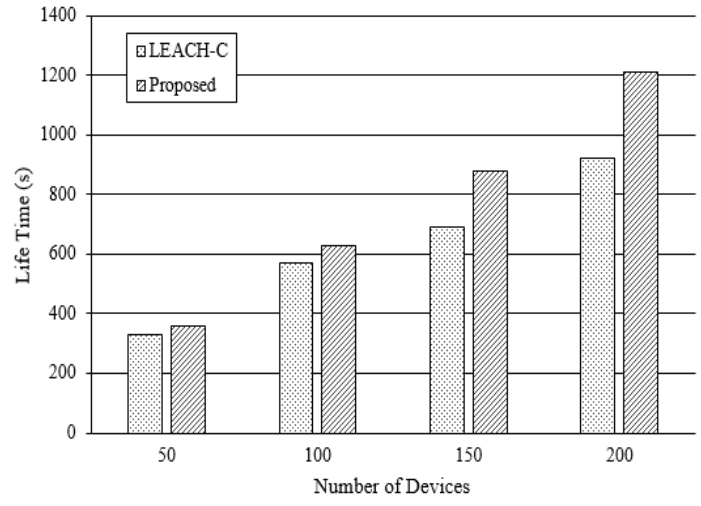
Figure 14. Life Time Comparison of Devices.